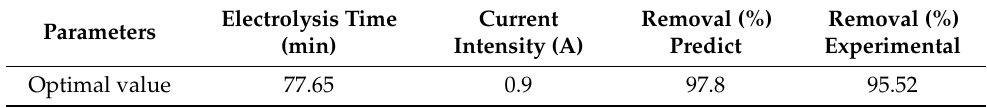
Figure 5. Contour plot of electrolysis time and current intensity on Pb removal at optimum condition. Table 5. Optimal condition and comparison between actual value and predicted value.